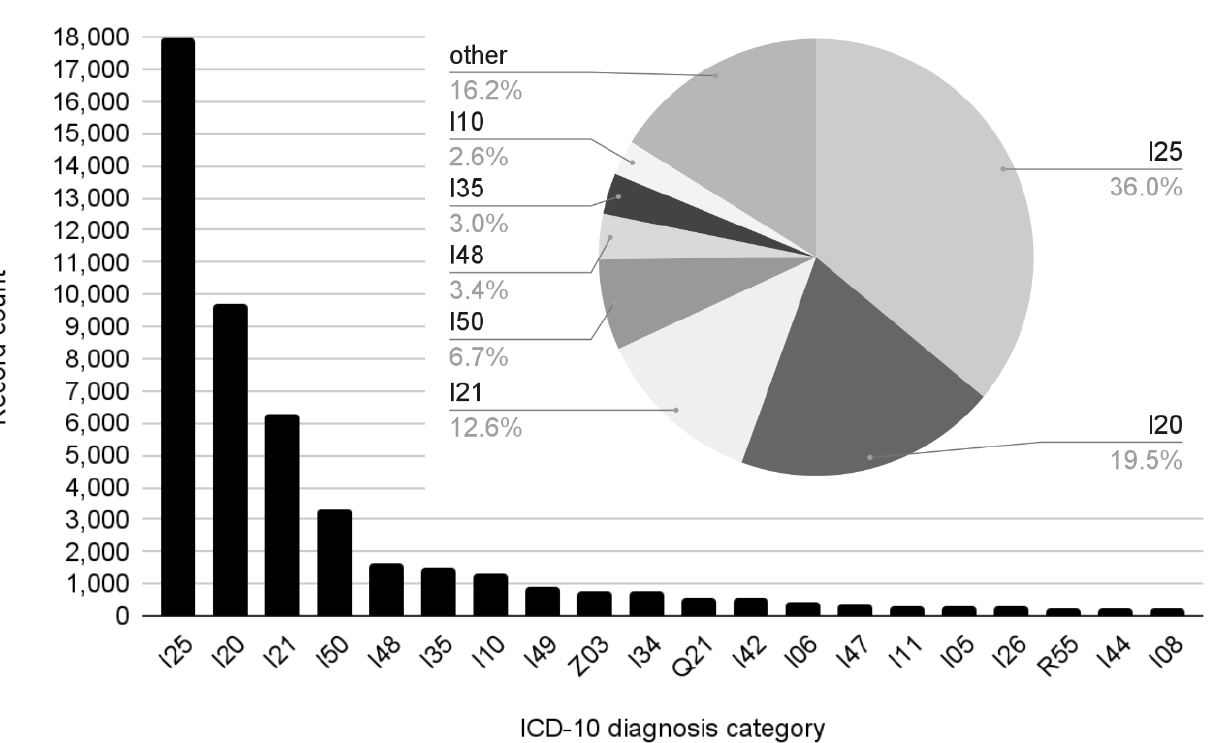
Figure 1. Representation of top 20 concluding ICD-10 categories in the data (bar chart) and propor- tions of categories with more than 1000 examples (pie chart). Table 3. Overview of the 10 most frequent concluding primary ICD-10 categories in the dataset. This distribution does not reflect realistic diagnosis frequencies because the conditions frequently co-occur and one health record in the dataset can only be assigned one diagnosis